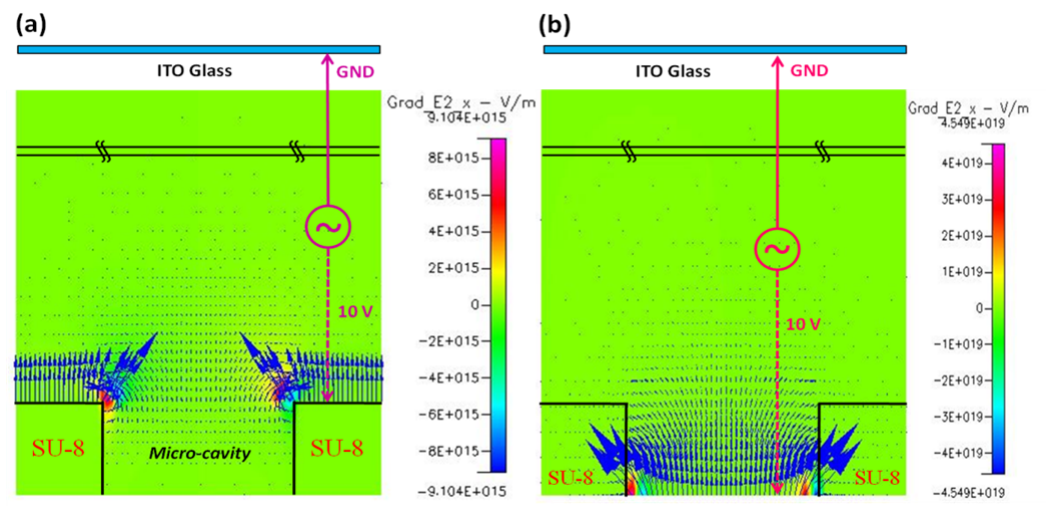
Figure 3. The vertical component of  E 2 : (a) Trapping cells by applied AC signal to top and middle electrodes; (b) Releasing cells by applied AC signal to top and bottom